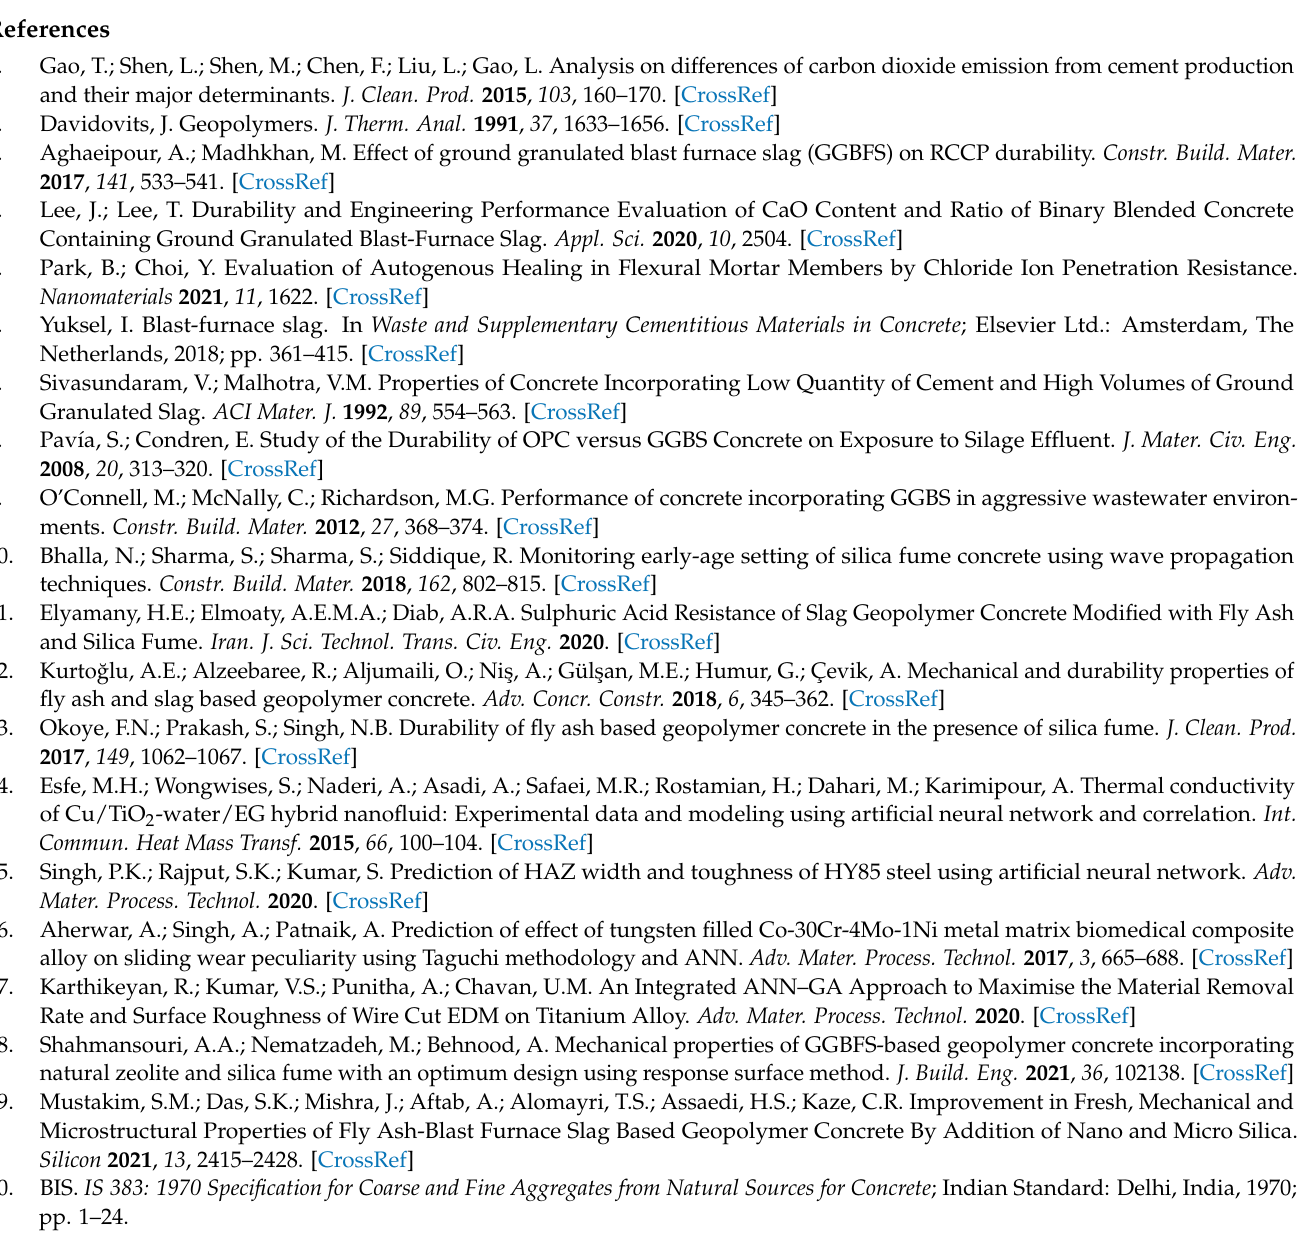
In the case of durability properties, the regression curve and data points showed a good correlation of compressive strength with RCPT, water absorption, and UPV